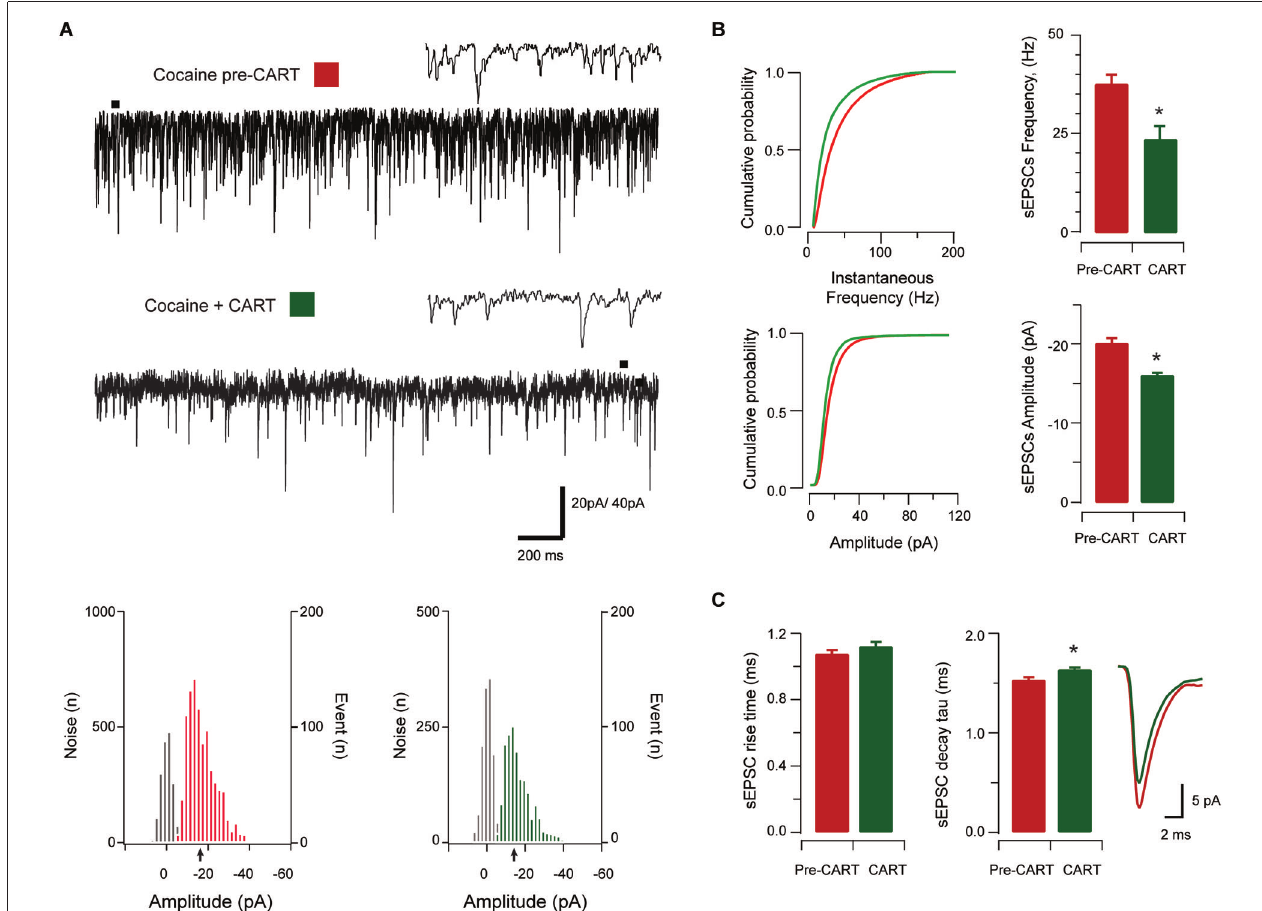
a significant reduction in both instantaneous frequency ( B, upper ) and amplitude ( B, lower ) of aPVT neurons in response to saline or cocaine. Group data plots ( C ) show sEPSC instantaneous frequency (* p < 0.001 ) , and amplitude ( * p < 0.001 ) were both reduced after CART application. We did not observe a significant effect of CART on rise time, however CART application resulted in a significant increase in decay time constant (* p = 0.11, an average of 1192 events and 669 events were analyzed respectively), with representative traces of rise and decay time pre- and